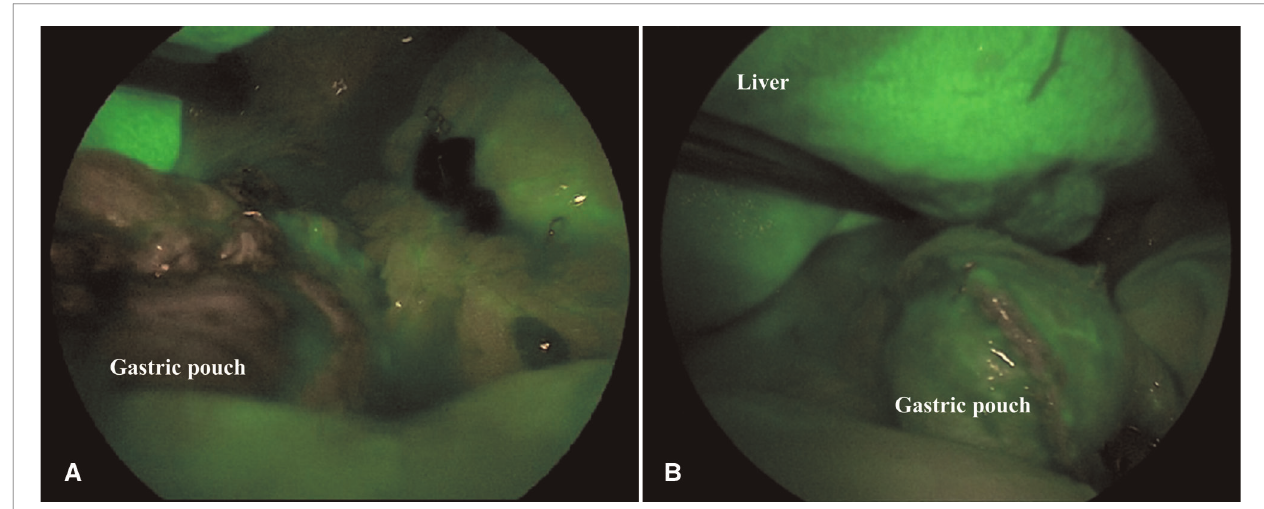
FIGURE 1 | Intraoperative satisfactory ICG-FA score. ICG-FA: Indocyanine green- fl uorescence angiography. ( A ) not perfused gastric pouch. ( B ) perfused gastric